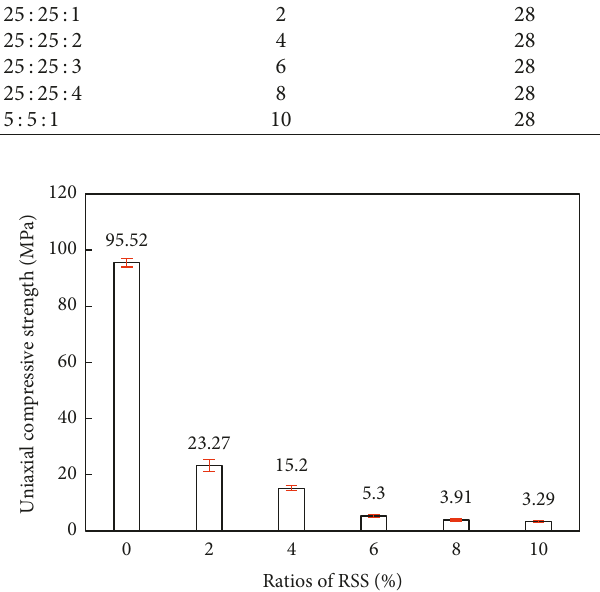
Figure 4: UCS of transparent hard rock-like materials with dif- ferent mass